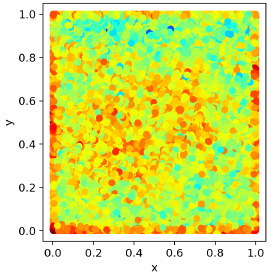
Figure 8. Target Position Heat